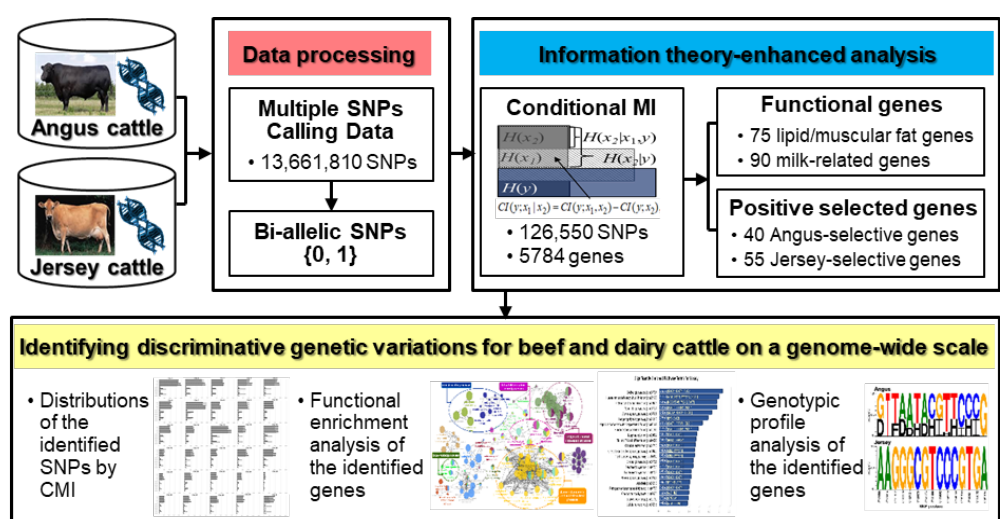
Figure 1. Schematic overview of information theory-enhanced analysis on cattle genome for identifying discriminative genetic variations between Angus and Jersey.